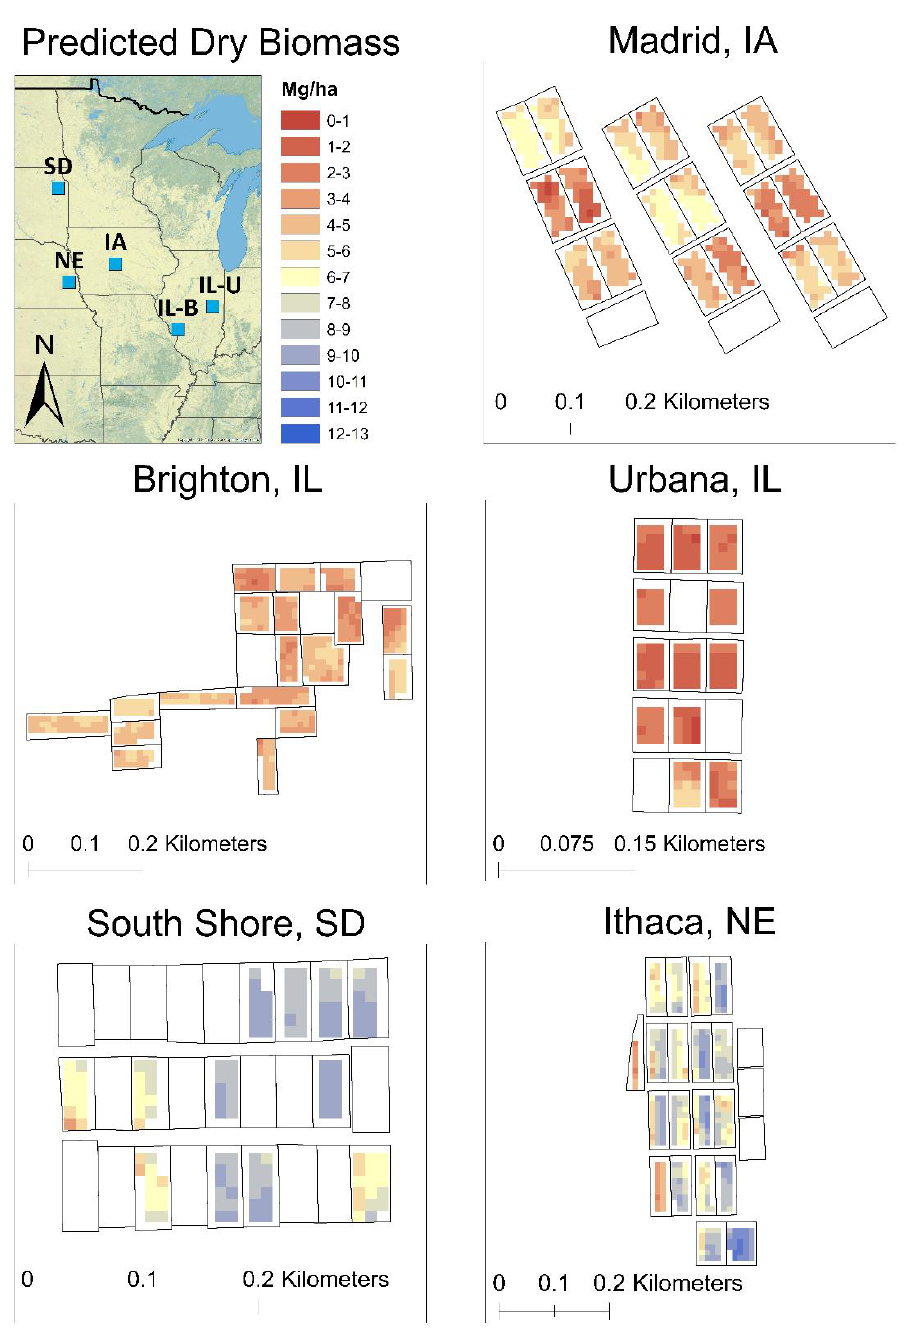
Figure 7. Examples of switchgrass dry biomass yield (Mg/ha) for the five study